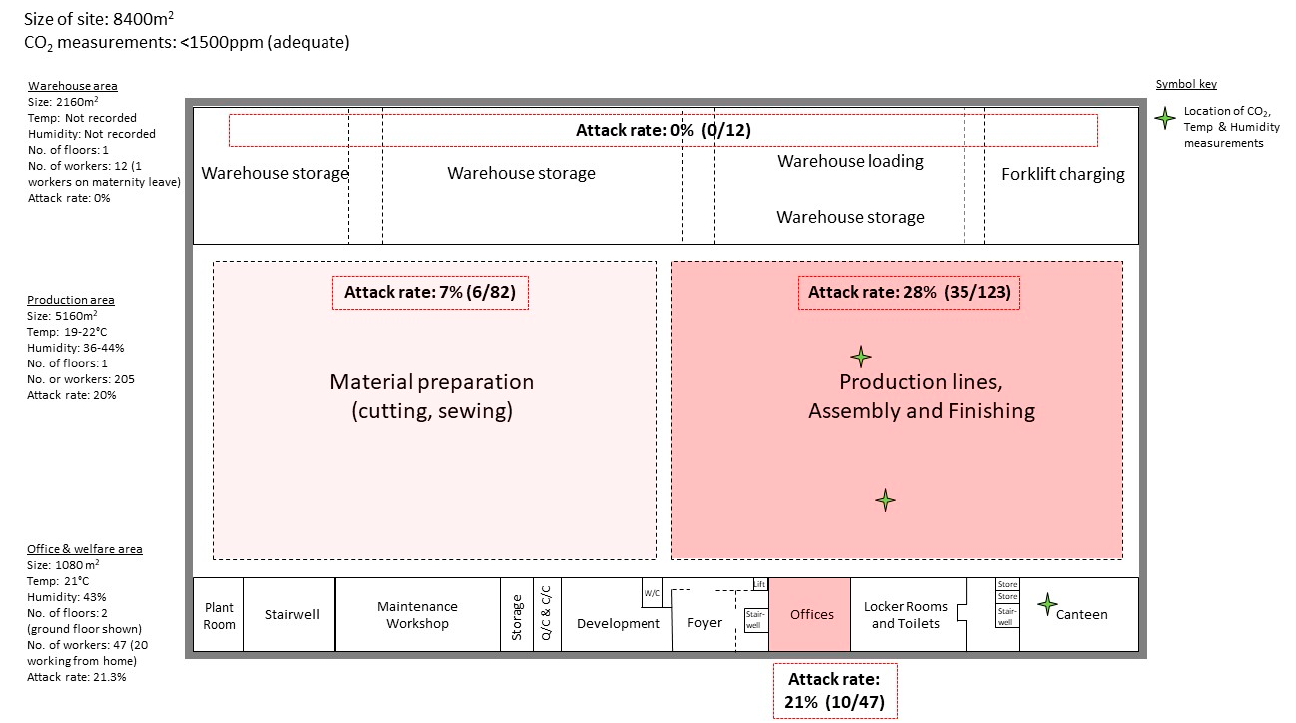
Figure 3. Site floor plan of the automotive manufacturing site—England, United Kingdom. Site divided into three main sections: warehouse, production, and office and welfare (e.g., canteen). The office and welfare section is split across two floors and only the first floor is shown in the figure. The second floor contains offices (enclosed and open-plan), meeting rooms, toilets, and small canteen. The attack rate for specific areas was calculated by the number of positive cases in area divided by the total number of workers for the area. The volumes have been approximated for each section and do not account for the slopes of the ceilings. Abbreviations: Quality control (QC), Climate control (CC), W/C (Water closet), and Temperature (Temp).